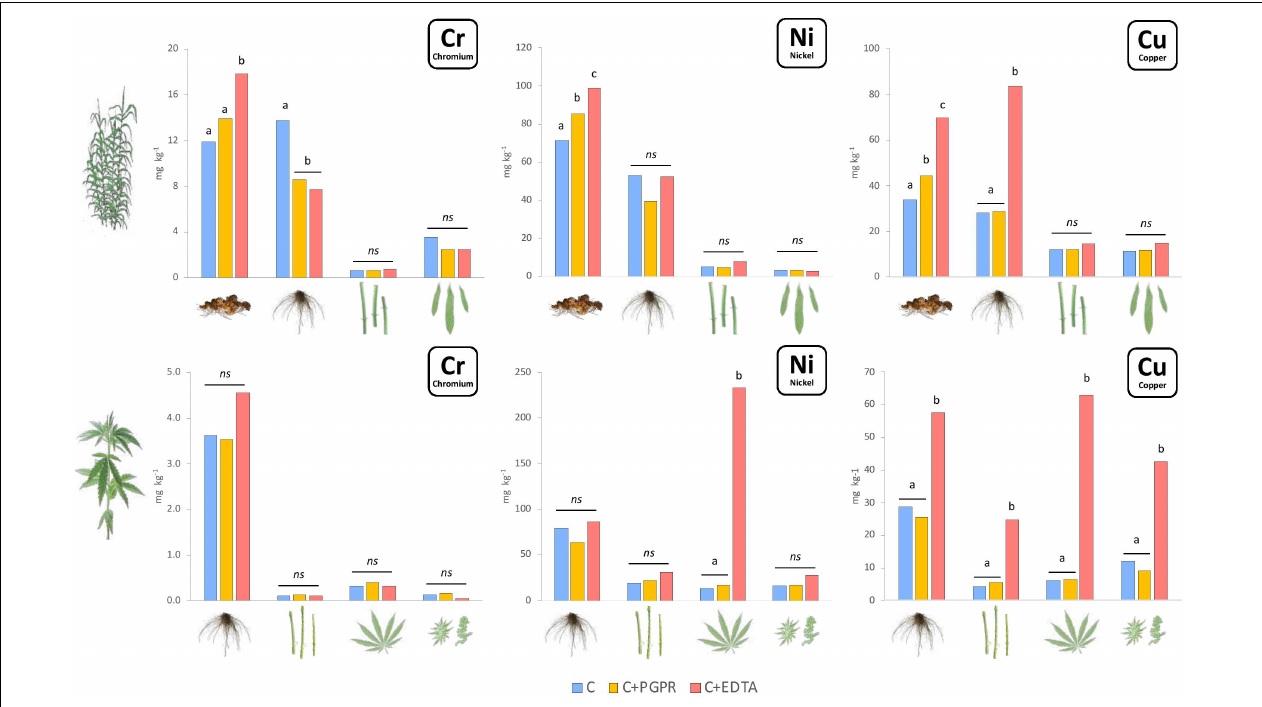
FIGURE 1 | Mean values of Cr, Ni, and Cu concentration (mg kg − 1 ) in plant components for hemp (roots, stems, leaves, and flowers) and giant reed (rhizome, roots, stems, and leaves) as affected by treatments. Different letters denote statistically different (Tukey’s test, P = 0.05) concentration values among treatment for each HM/crop